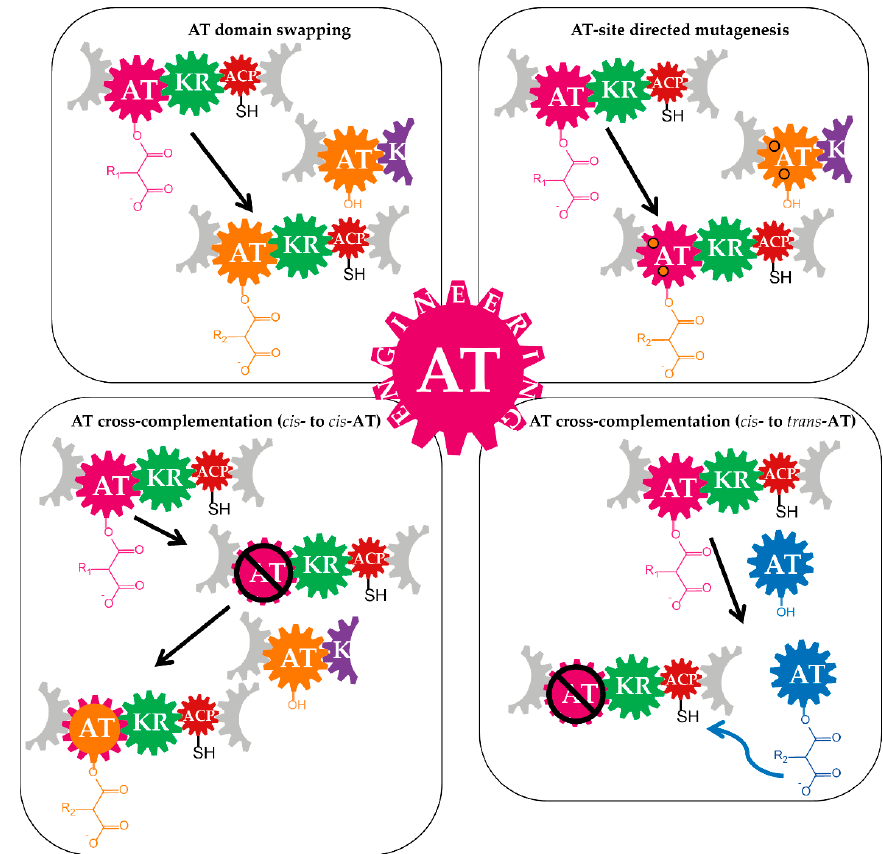
Figure 3. General strategies for acyltransferase-based engineering of polyketide synthases. The acyltransferase (AT)-based engineering of polyketide synthases (PKSs) includes the AT